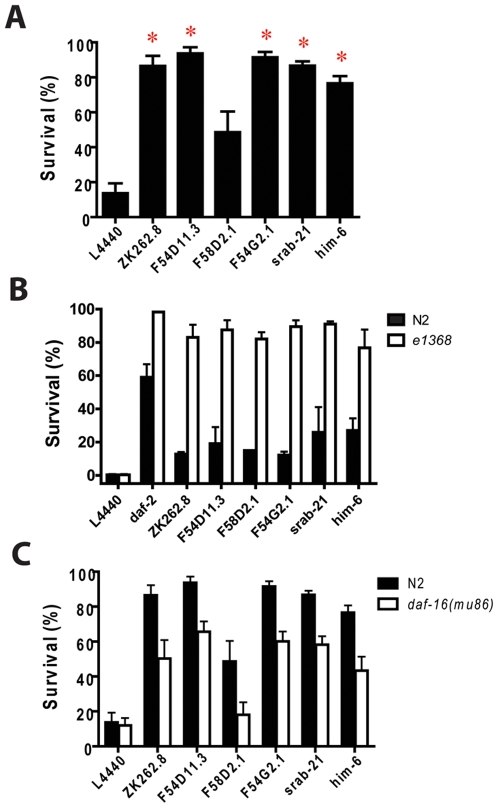
Survival from hypoxia by RNAi knockdown of die genes.Genetic background of strains is indicated by closed (wild type - N2) or open bars (mutant – either daf-2(e1368) or daf-16(mu86)). Note that survival data are after a 22 hour hypoxic incubation for the upper and lower panels and are after a 24 hour hypoxic incubation for the middle panel. (A) Survival after recovery from a 22 hour hypoxic incubation for N2 wild type animals treated with bacteria transfected with L4440 empty vector or with RNAi plasmids against die genes. * p<0.01 compared to L4440 (two-tailed t-test, 6 trials/RNAi with >30 worms/trial). (B) Effect of RNAi treatments on survival after a 24 hour hypoxic incubation in wild type and daf-2(e1368) backgrounds. All RNAi's resistance in an e1368 background compared to L4440 – p<0.01 (two-tailed t-test, 3 trials/RNAi with >30 worms/trial) (C) Effect of RNAi treatments on survival after a 22 hour hypoxic incubation in wild type and daf-16(mu86 null) backgrounds. Hypoxia resistance significantly suppressed in mu86 background for all RNAi's – p<0.01 (paired t-test, 6 trials/RNAi with >30 worms/trial).